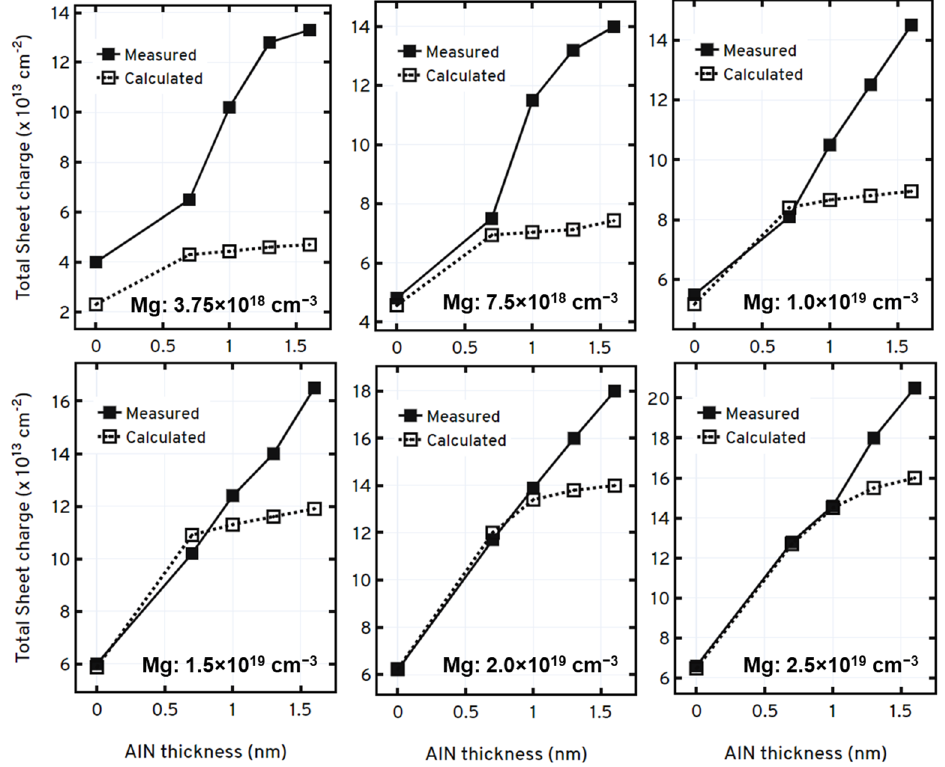
Figure 3. Results for Hall effect measurements conducted at room temperature on samples presented in this work. The figure shows the total sheet charge concentration of holes measured as the AlN layer thickness is varied for the different Mg doping levels used at each AlN thickness.